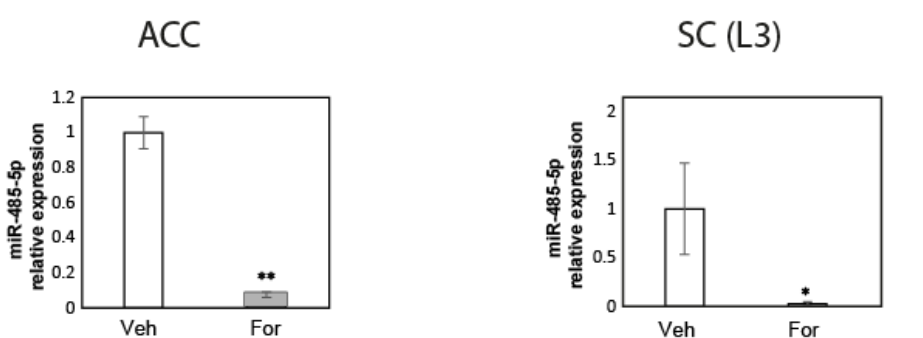
Figure 5. miR-485-5p levels in the pain pathway. Representative plot of miR-485-5p relativized to GAPDH (2ddCT) in ACC contralateral regions ( left ), and SC at L3 ( right ). The plots represent one of five (ACC) or three (SC) biological replicates showing the same differences between Veh- and For- treated samples. One of three biological replicates ± SE is shown. * p < 0.05, ** p < 0.01, two-tailed unpaired t -test.